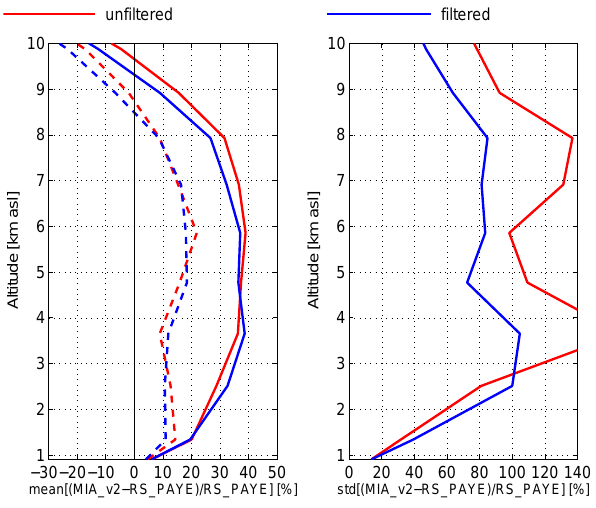
Fig. 14. Statistics from 2007 until 2010 (4h averaged spectra). “un- filtered” includes all retrieval-sounding pairs, “filtered” is restricted to cases, in which the sonde was driven towards Northeast-East as seen from Payerne, i.e. in direction of MIAWARA location. Dashed lines indicate the